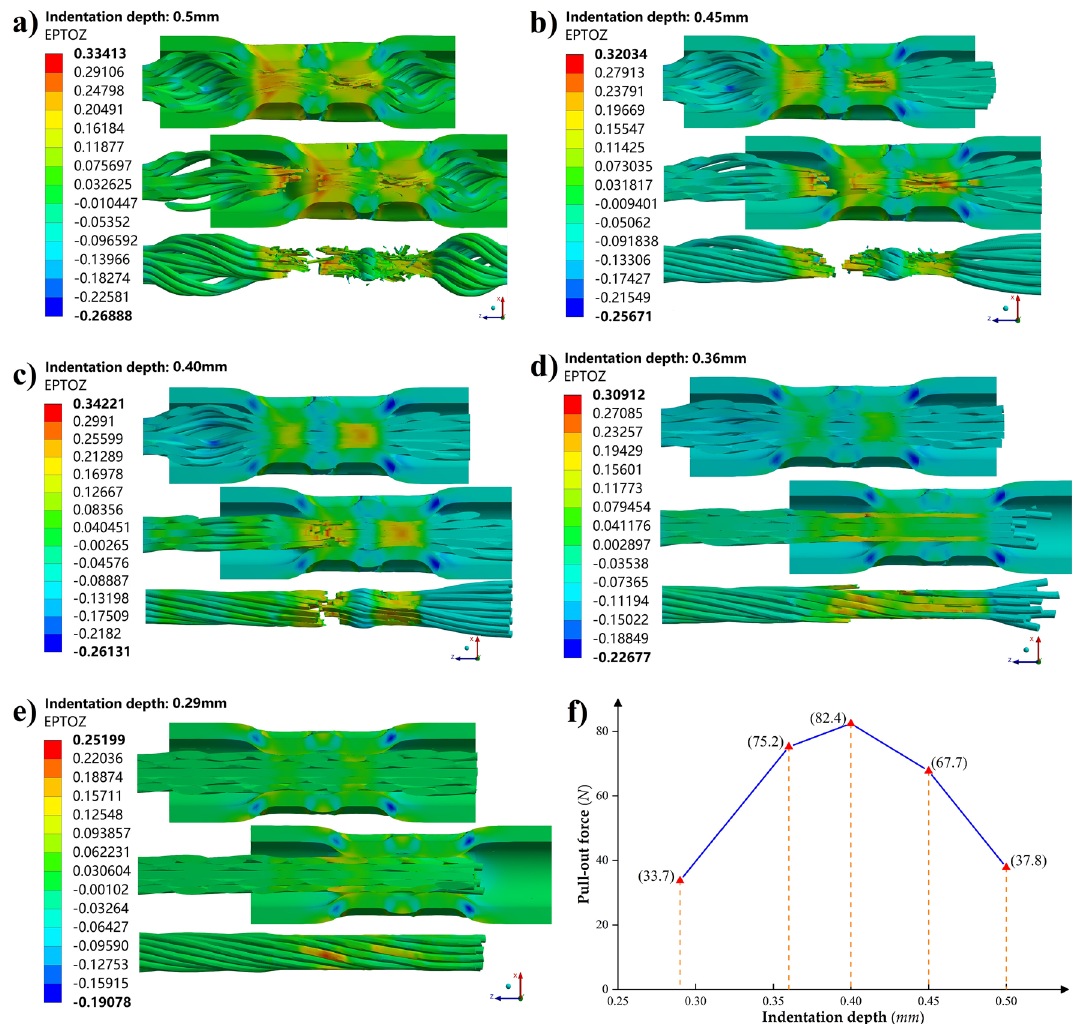
Figure 11. Tensile simulation results of the crimping assembly at the indentation depth corresponding to the 1 ~ 5# gear. The indentation depths are respectively taken as: ( a ) 0.5 mm; ( b ) 0.45 mm; ( c ) 0.4 mm; ( d ) 0.36 mm; ( e ) 0.29 mm. ( f ) The pull-out force of crimp terminals for each indentation depth.